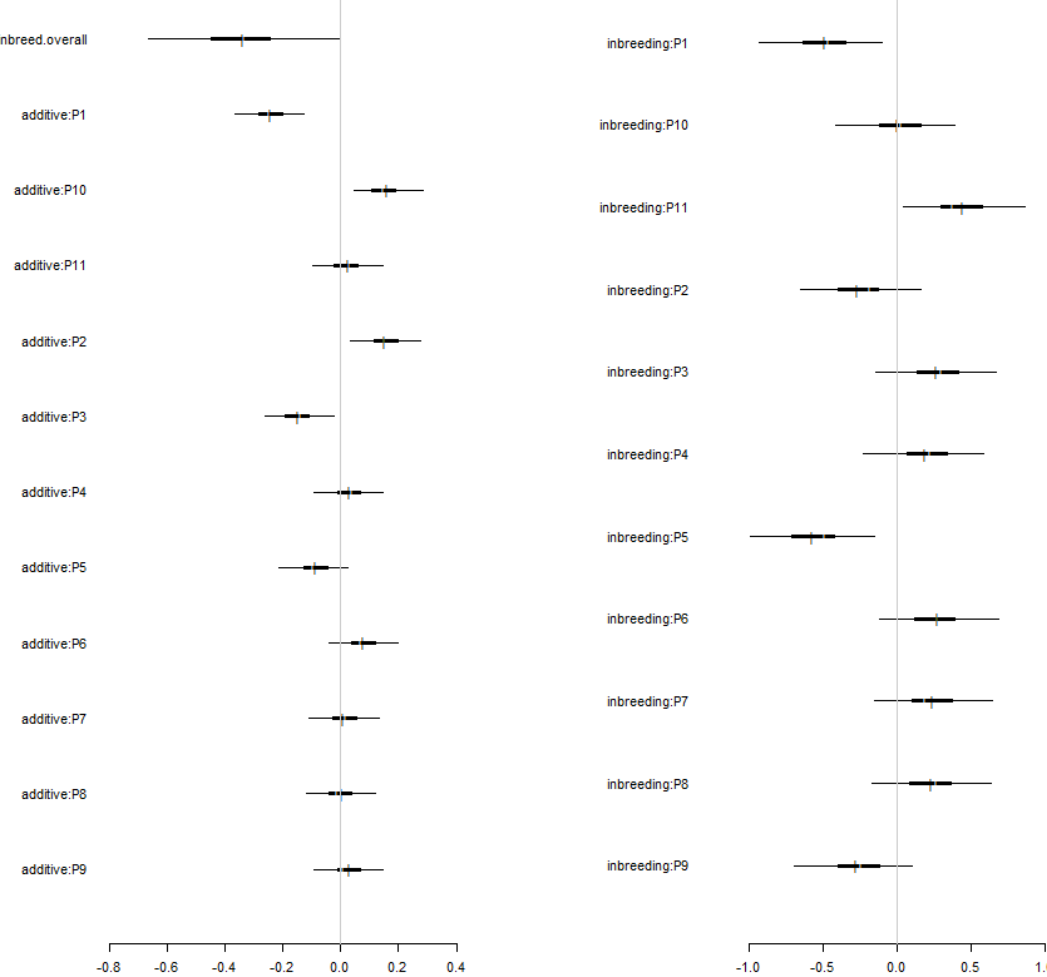
Figure 5. Diallel variance projections of the genetic architecture for total yield.